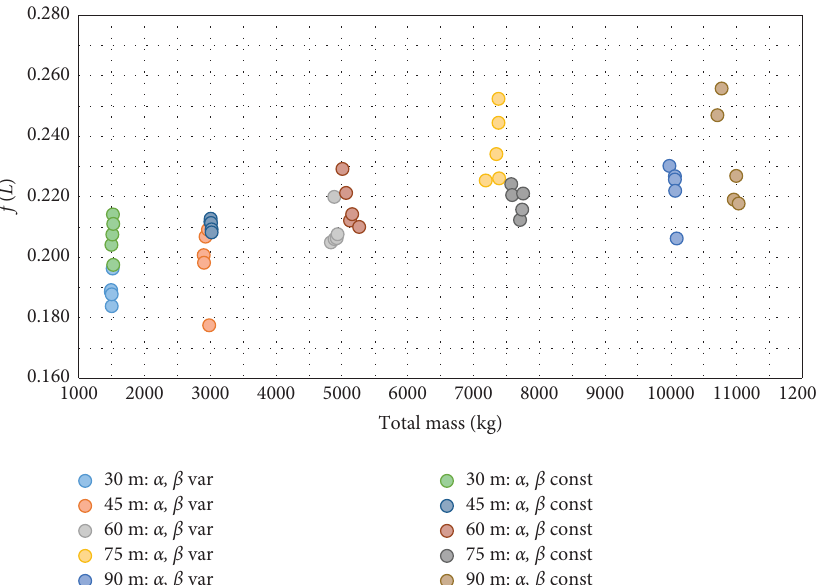
Figure 6: Five best values of ratio f / L at variable and constant angles α and β for all spans, and R ≥ 20mm.